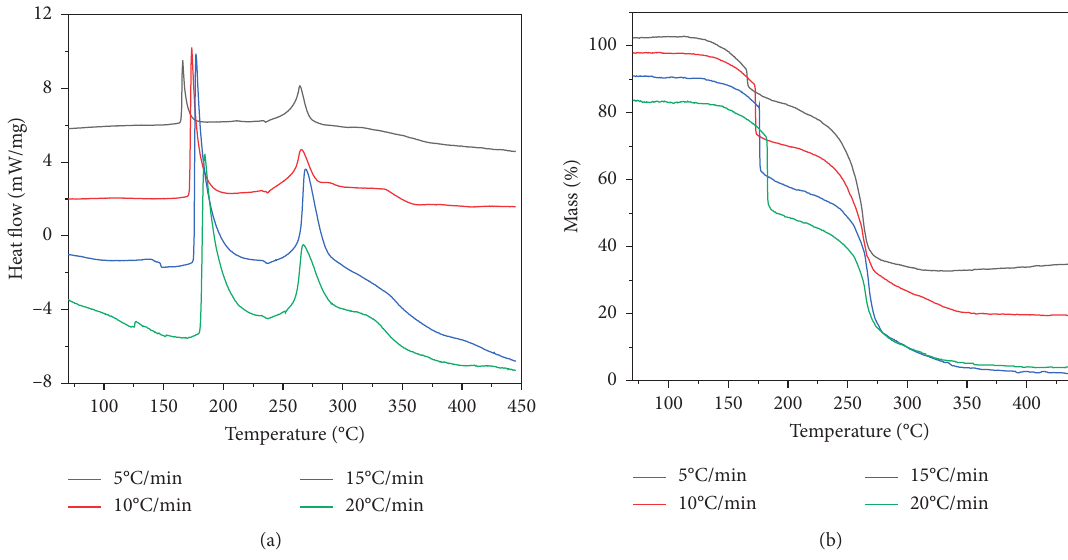
Figure 9: DSC and TG curves of NEPE at different heating